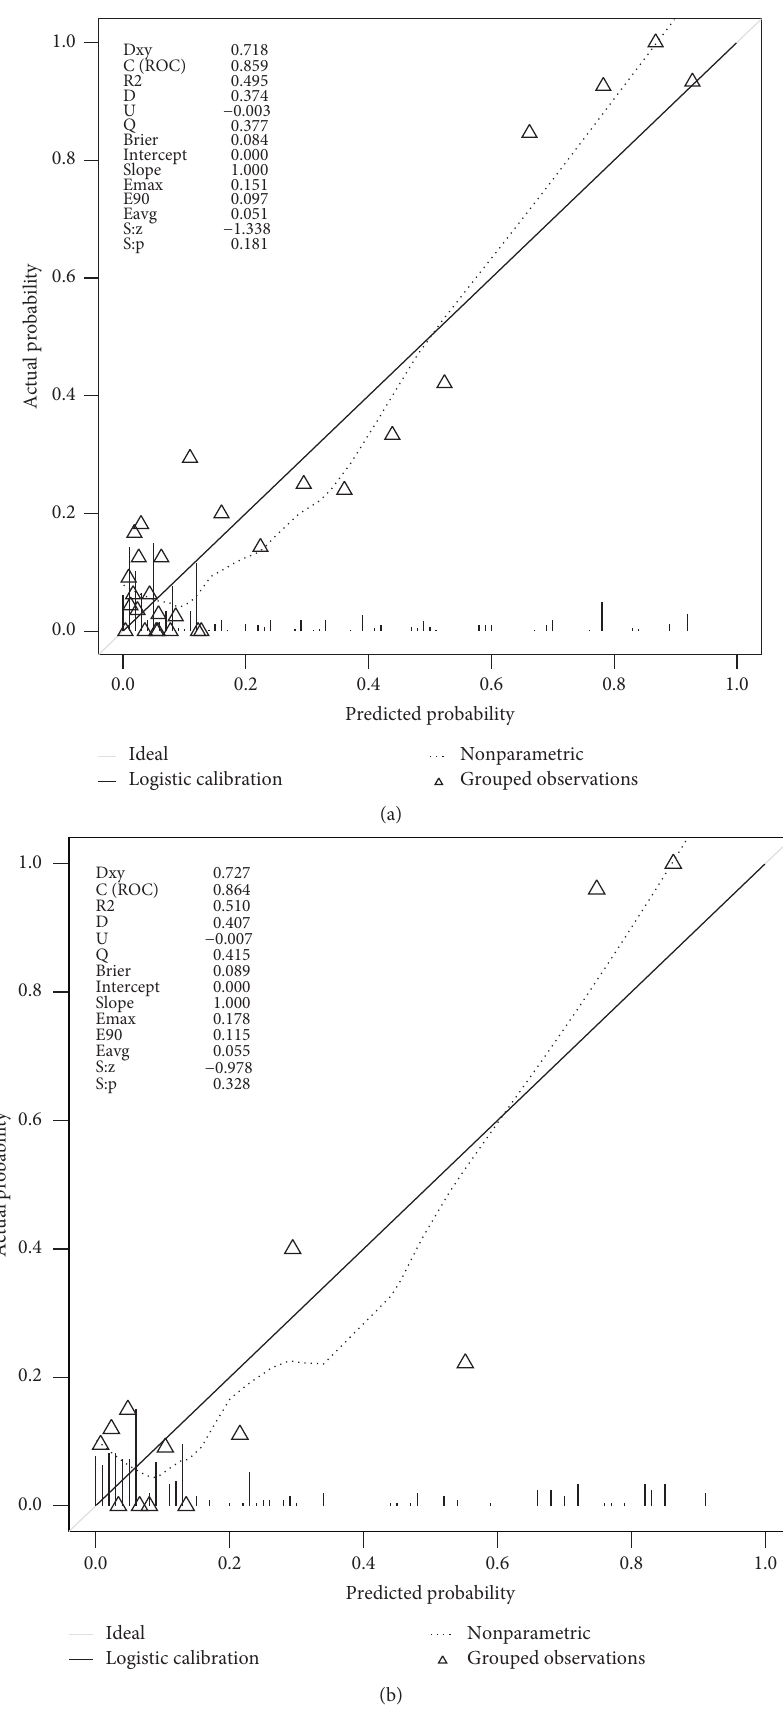
Figure 5: Calibration curves of the nomogram in the training set (a) and validation set (b). The x -axis represents the predicted untreated risk. The y -axis represents the actual identified untreated patients. The diagonal dotted line represents a perfect prediction by an ideal model. The solid line represents the performance of the nomogram, of which a closer fit to the diagonal dotted line represents a better